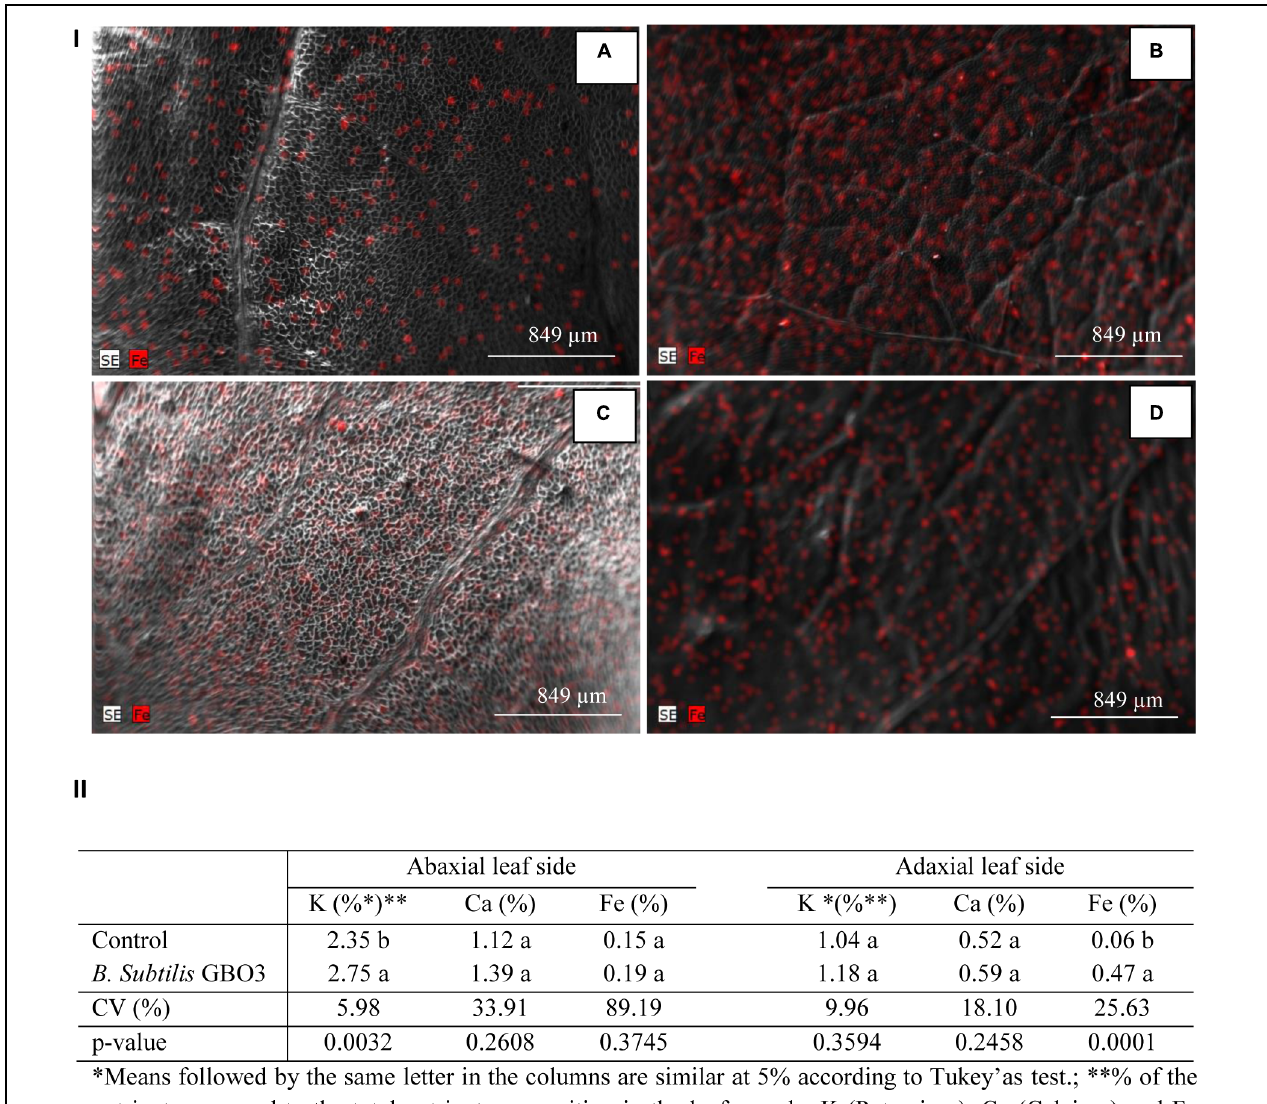
FIGURE 2 | Scanning electromicrography X-ray analysis of (I) the abaxial (A,C) and adaxial (B,D) leaf sides of cassava ( M. esculenta ) bacterized with B. subtilis GBO3 (A,B) or water (C,D). Red colored dots represent the presence and abundance of